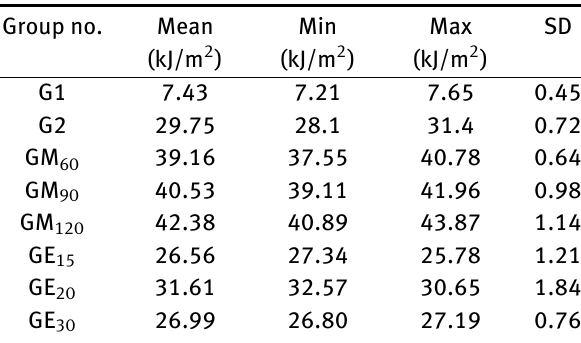
Table 2: The measured Charpy impact (I.S.) strength for the pre- pared dentures Group